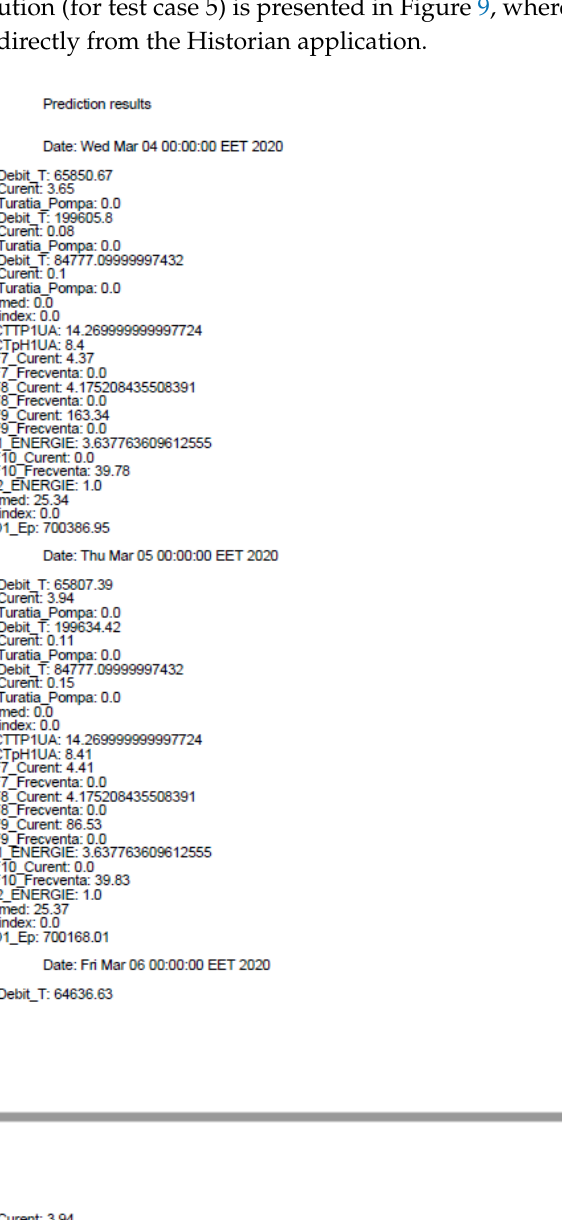
Figure 9. Prediction algorithm output for test case 5.